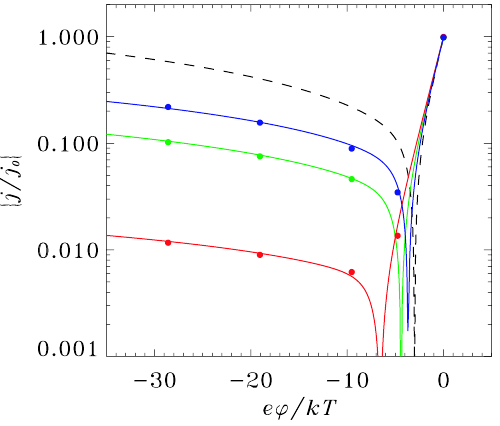
Fig. 7. Normalised current versus normalised potential in an H + Fig. 7 plasma with V 0 =0 (black), V 0 = V Ti (blue), V 0 =2 V Ti (green) and in the O + plasma with V 0 = 4 V Ti . Dots stand for the computed values and their fit is shown as a solid line. Plasma and probe characteris- tics are identical as in Fig.